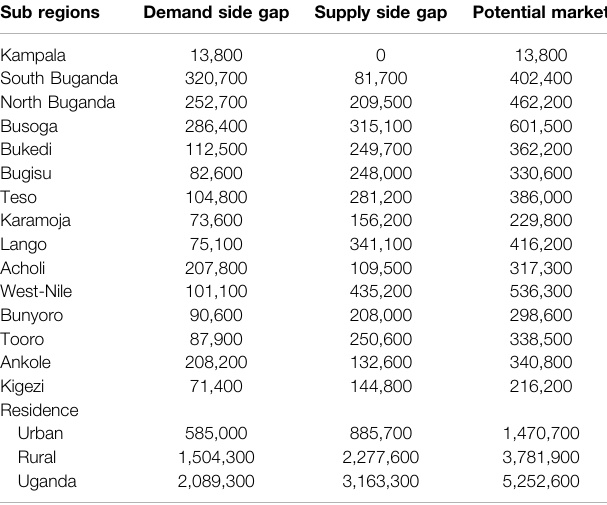
TABLE 2 | Total market potential by residence and